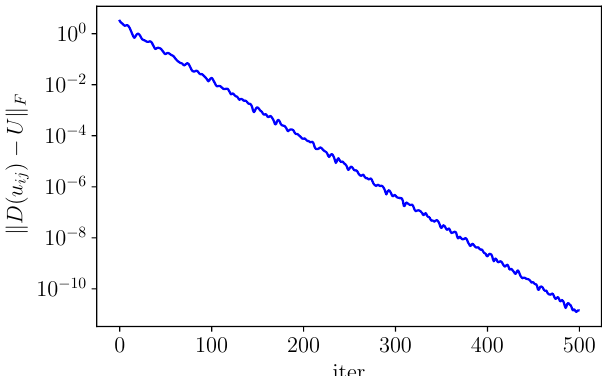
Figure 6: Frobenius distance between a gate and its decomposition. One can see that the distance rapidly decreases with the number of iteration towards nearly zero within machine